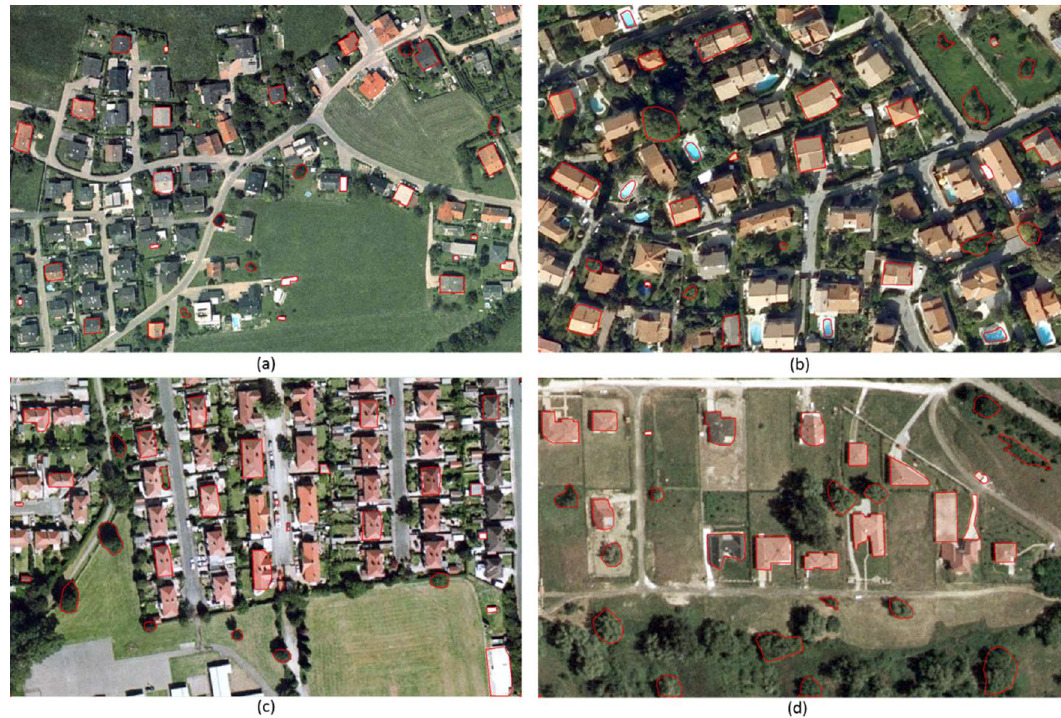
Figure 12. The UE results of the segmentations produced by the MRS method with different combination methods, using the SZTAKI-INRIA building detection dataset: ( a ) Bodensee, ( b ) Cot d’Azur, ( c ) Manchester, and ( d ) Szada.